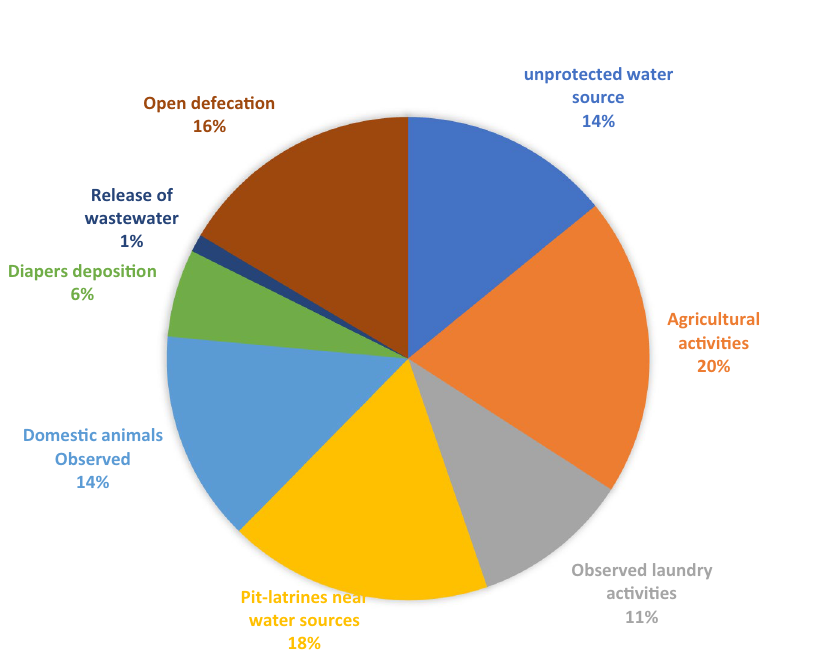
Figure 1. A pie chart showing observed activities near water sources in the Vhembe District